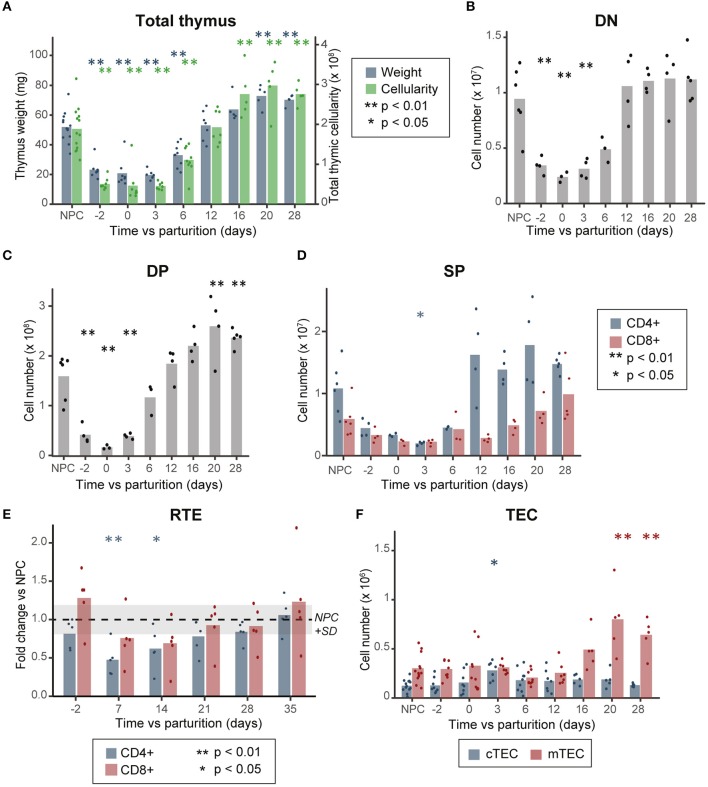
Thymocyte loss during pregnancy does not correlate with a decrease in TEC numbers. (A) Thymic mass (mg) and cellularity (×108, n = 5–13). (B) Cell numbers of DN, (C) DP, and (D) SP thymocytes (n = 3–6). (E) Variation in thymic output, as measured by the percentage of recent thymic emigrants (RTE, n = 5). (F) TEC numbers (×106, n = 5–13). NPC refers to the non-pregnant controls, D-2 to pregnant females at day 18 of gestation and D0 to the day of parturition. All analyses were performed in thymi of B6.SJL mice except for those depicted in (E) where we used peripheral blood of RAG2p-GFP female mice. Means are displayed as bars, each dot representing an individual. Significance was assessed with one-way ANOVA followed by post-hoc Tukey test. p-values (*p < 0.05 and **p < 0.01) are shown against NPC only.